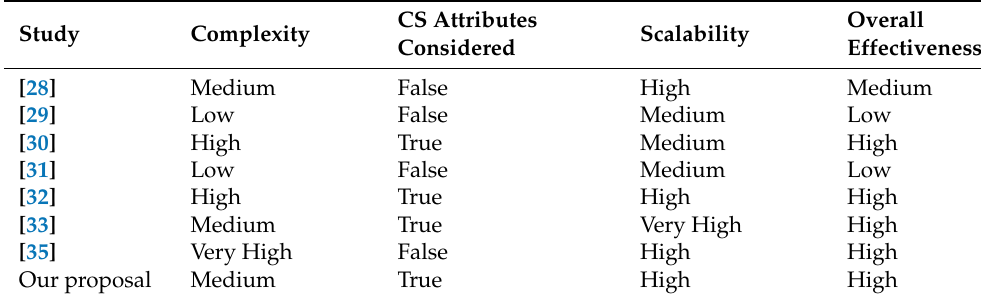
Table 1. Comparative